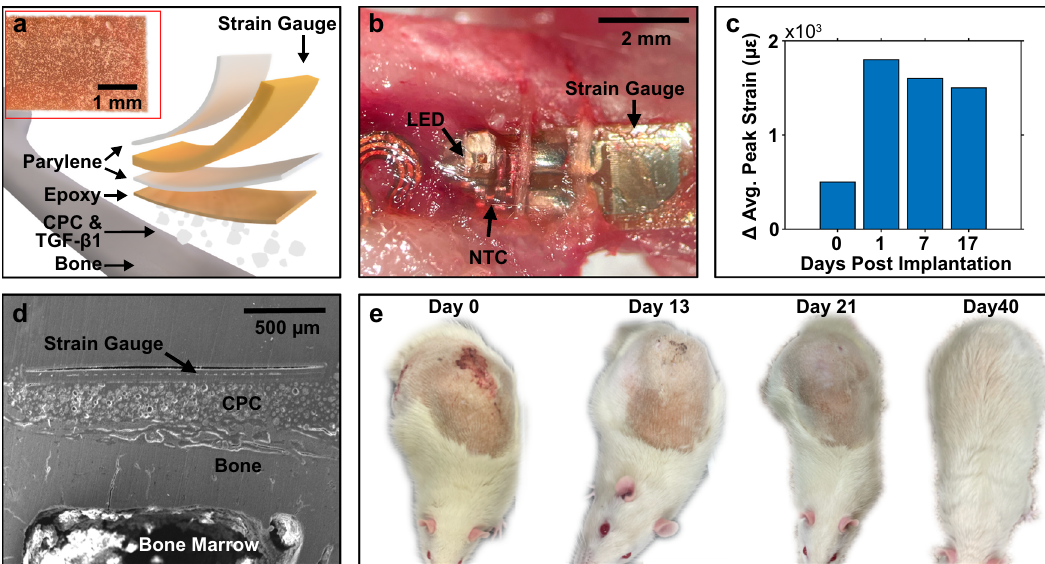
Fig. 6 Promotion of osteogenesis using surface-engineered calcium phosphate ceramic coatings. a Photograph of the bottom coated with CPC and a side view diagram of layer composition of the strain gauge sensor with CPC. b Image of the device 3 weeks post implantation. c Wireless strain gauge data collected over 2 weeks post implantation showing stable CPC adhesion. d Single electron microscope image of cross-section of CPC adhesion to bone. e Animal healing after